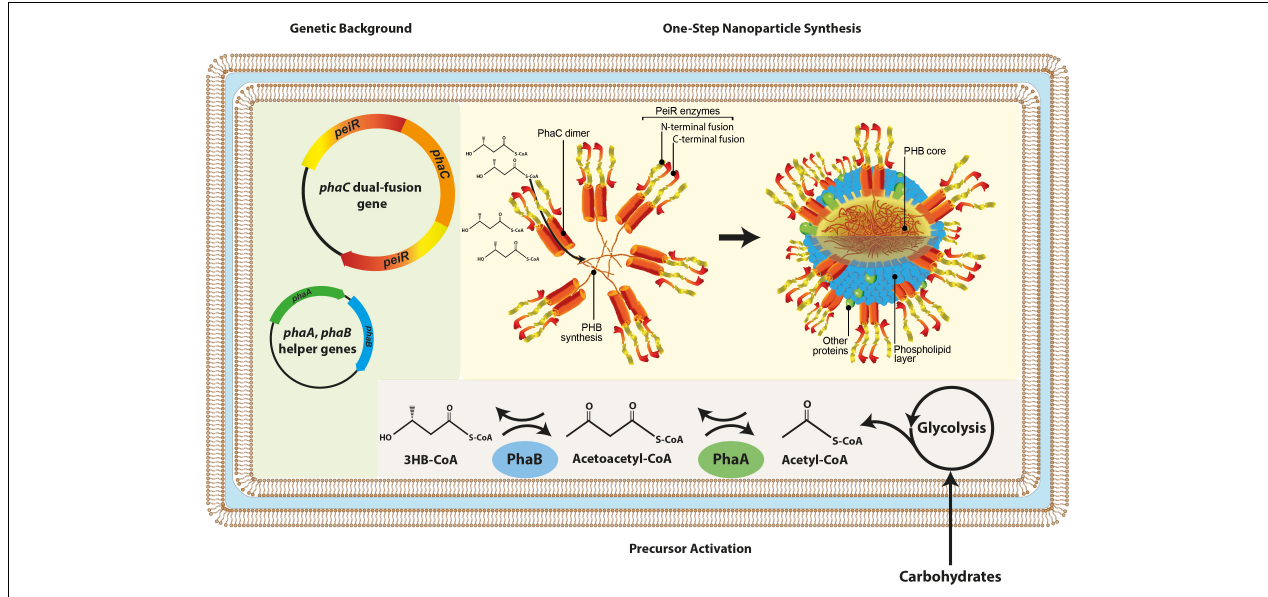
FIGURE 1 | Schematic presentation of in vivo nanoparticle synthesis. The graphic representation depicts the genetic backbone (light green background) used for dual-fusion functionalized nanoparticles, subsequent redirection and activation of metabolic precursors (gray background) and the one-step